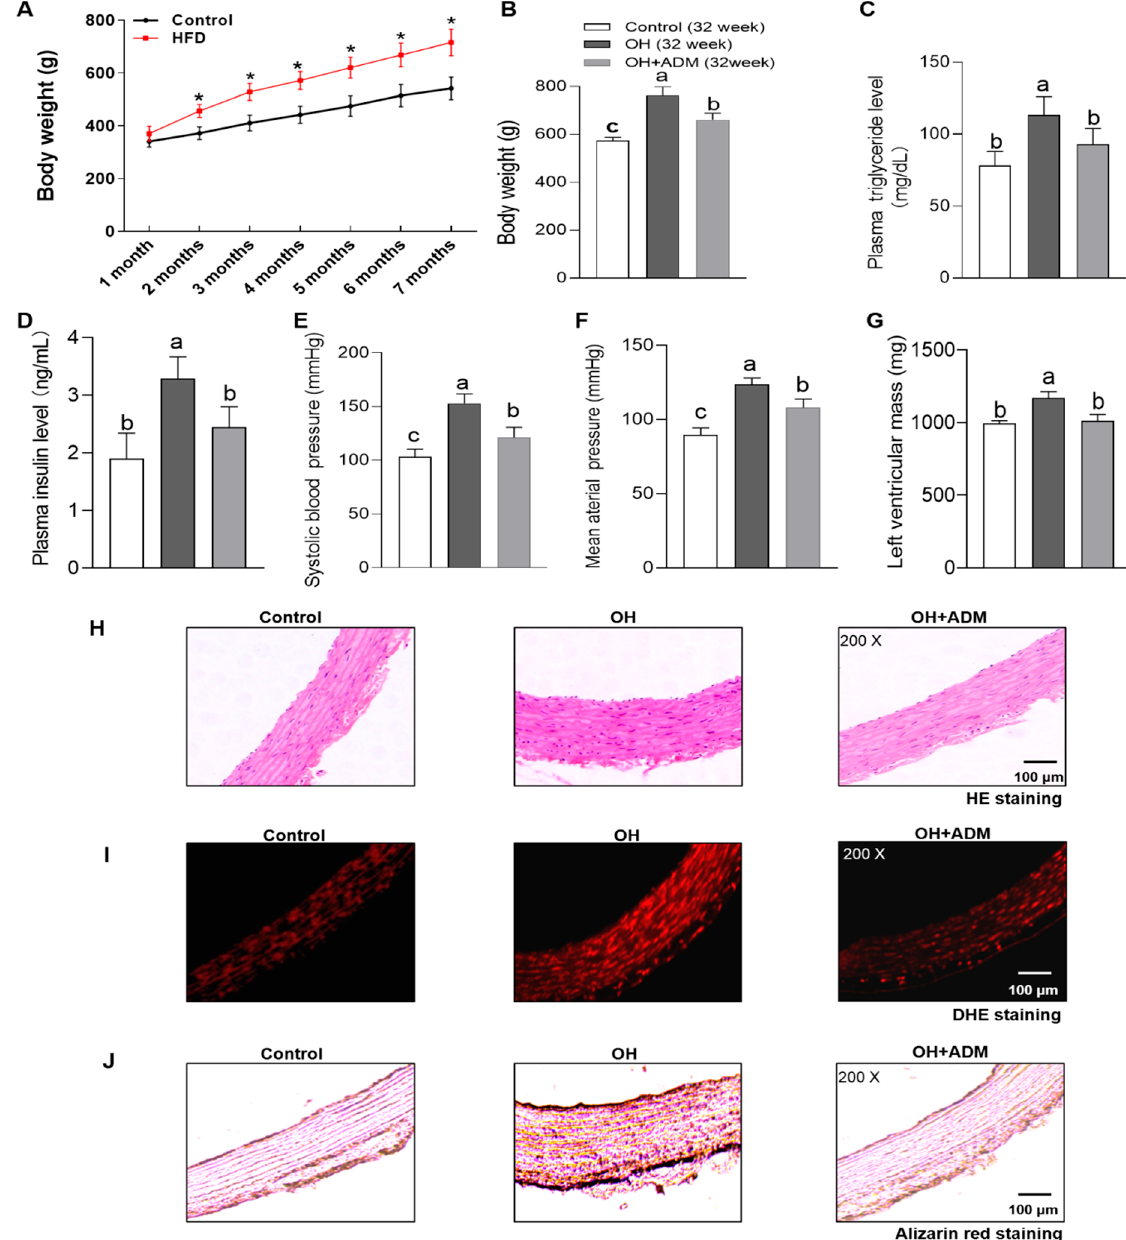
Figure 1 . Body weight at the end of each month in rats fed with control diet or high fat diet (HFD) for 7 months ( A ) and the effects of Adrenomedullin (ADM, 7.2 μ g/kg/day, ip) application for 4 weeks on body weight ( B ), plasma triglyceride and insulin levels ( C , D ), systolic blood pressure ( E ), mean arterial pressure ( F ), left ventricular mass ( G ), vascular remodeling (( H ), HE staining), reactive oxygen species (ROS) level (( I ), DHE fluorescence staining) and calcification (( J ), alizarin red staining) in the tunica media of aorta after 32 weeks of HFD feeding. OH: obesity-related hypertension. The Control and OH rats were treated with saline (vehicle). n = 5–8 rats for each group. Values are presented as mean ±SEM. * p < 0.05 vs. Control (A, two-way ANOVA followed by Bonferroni post hoc analysis). Values with the same superscript letter are not significantly different and the different letters indicate significant differences between the groups ( p < 0.05, one-way ANOVA followed by Bonferroni post hoc analysis, ( B – G )).